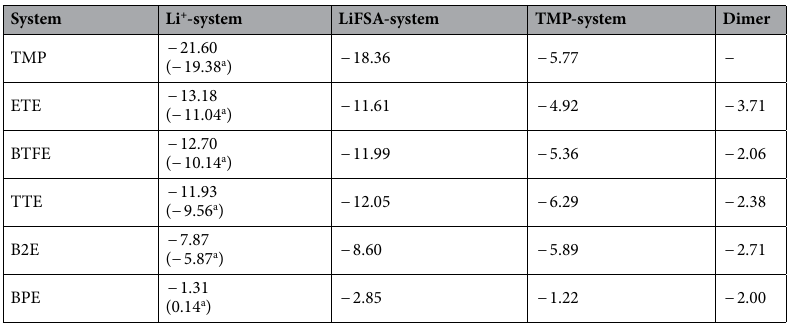
Table 2. The interaction energy (kcal/mol) between Li + , LiFSA and TMP with various systems (solvent or diluents) as well as the interaction energy (kcal/mol) between the diluents themselves (dimer) as obtained at M06-2X/def2-TZVP level in TMP ( ε = 20.6) solvent. a CCSD(T)/def2-TZVP ( ε = 20.6) //M06-2X/def2-TZVP ( ε =